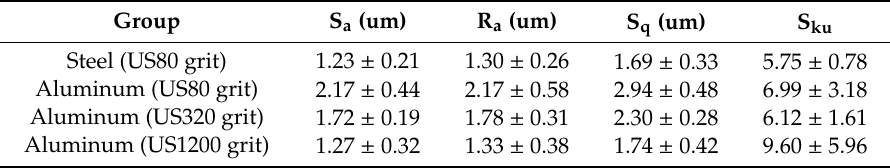
Table 3. Average profilometer value of surfaces used in shear